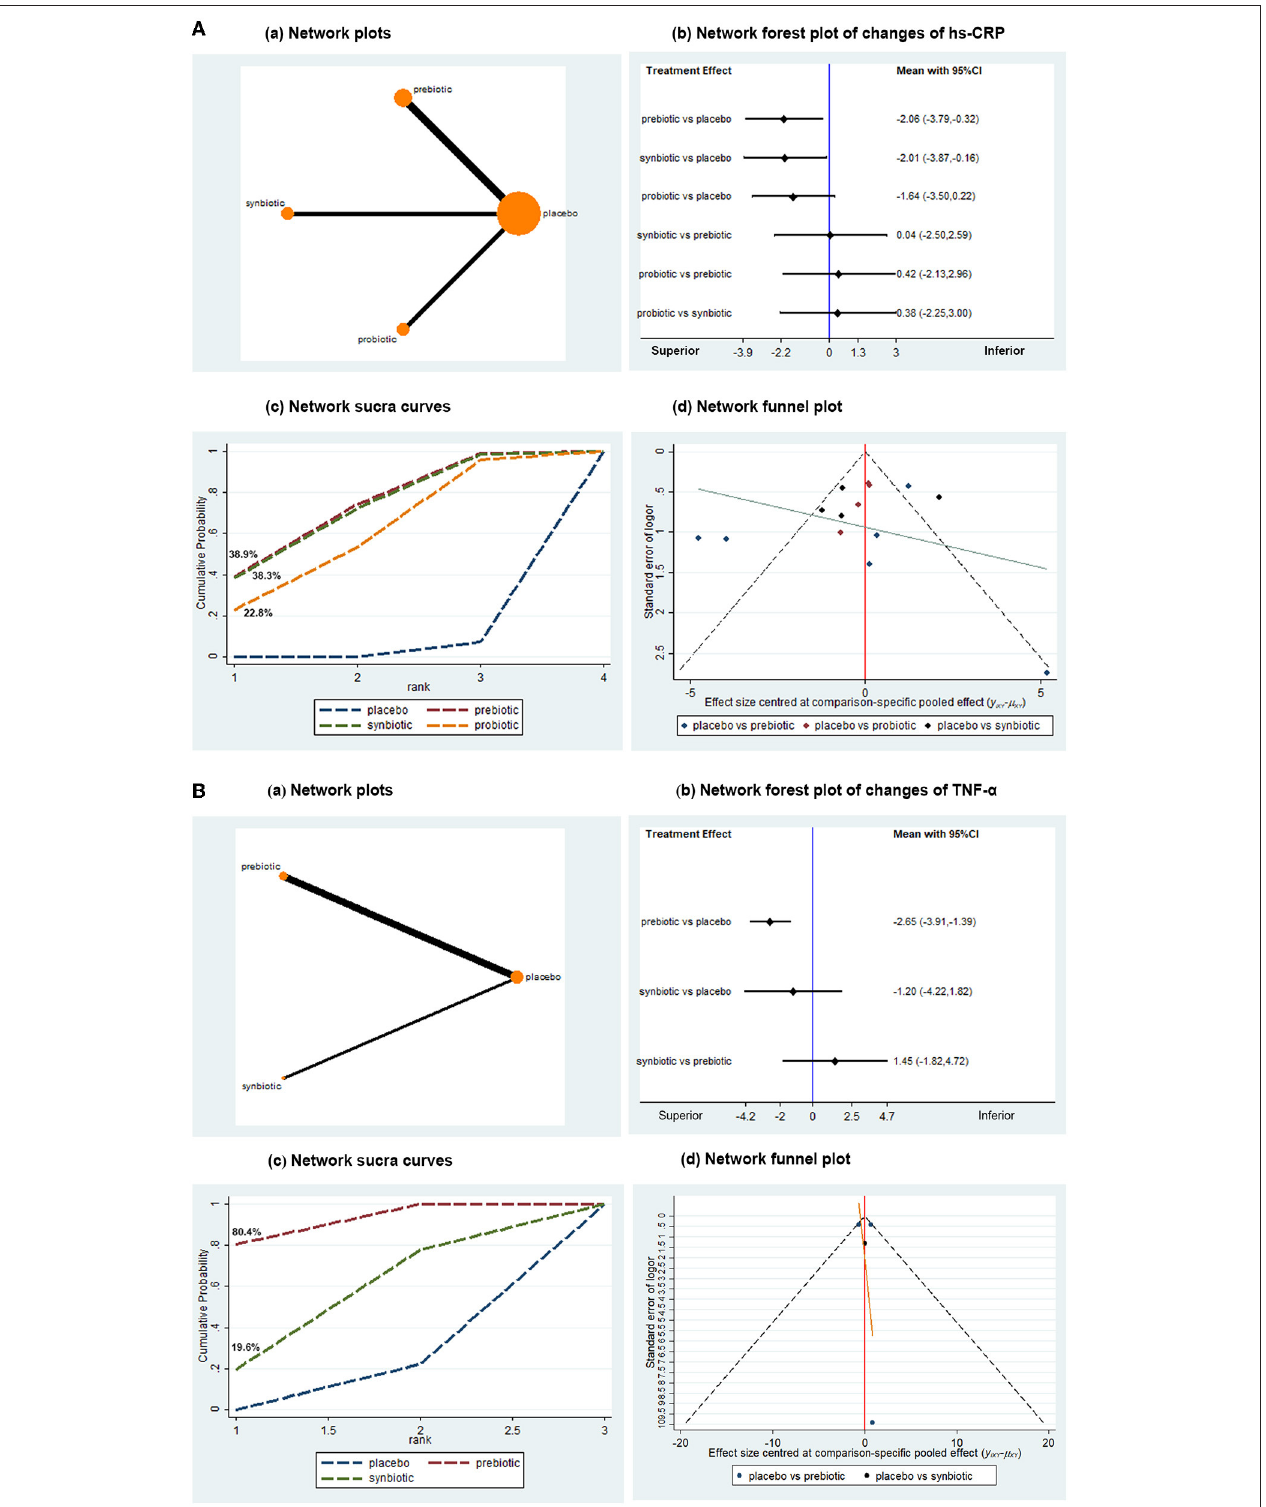
FIGURE 3 | Network meta-analysis results for the effects of probiotic, prebiotic, and synbiotic supplementation on hs-CRP (A) and TNF- α (B) . hs-CRP, high sensitivity C-reactive protein; TNF- α , tumor necrosis factor- α .